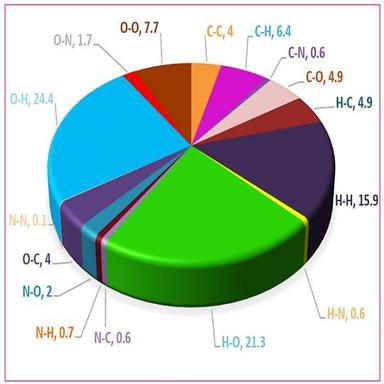
uantities of molecular interactions represented in a pie chart